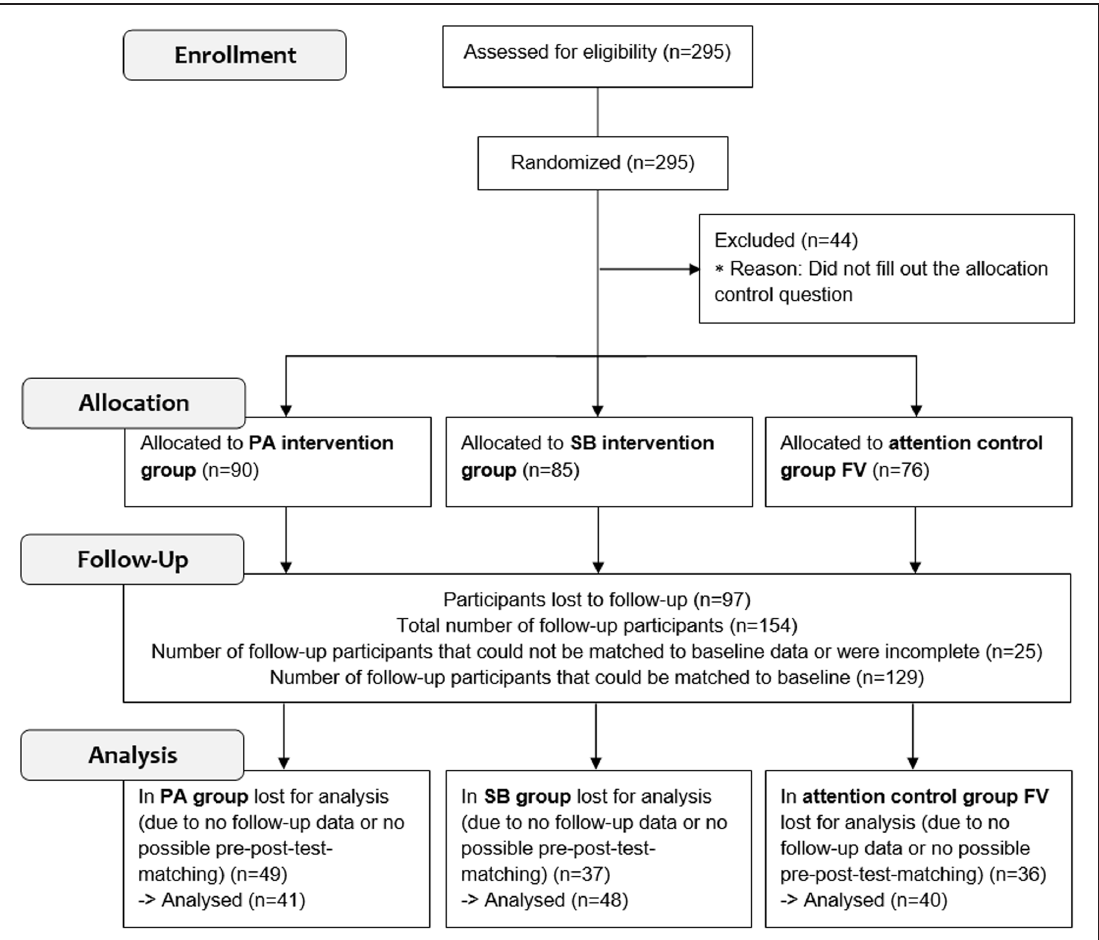
Figure 1 CONSORT participant flow